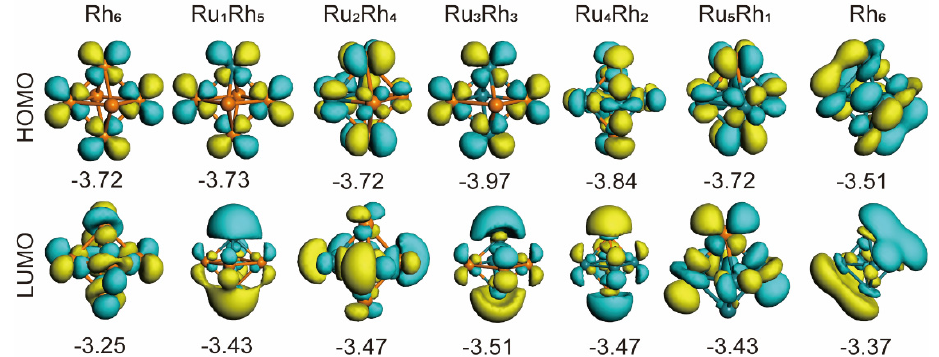
Figure 3. HOMO and LUMO for the octahedral Ru m Rh n clusters system (the contour value is 0.03 electron/Å 3 ).